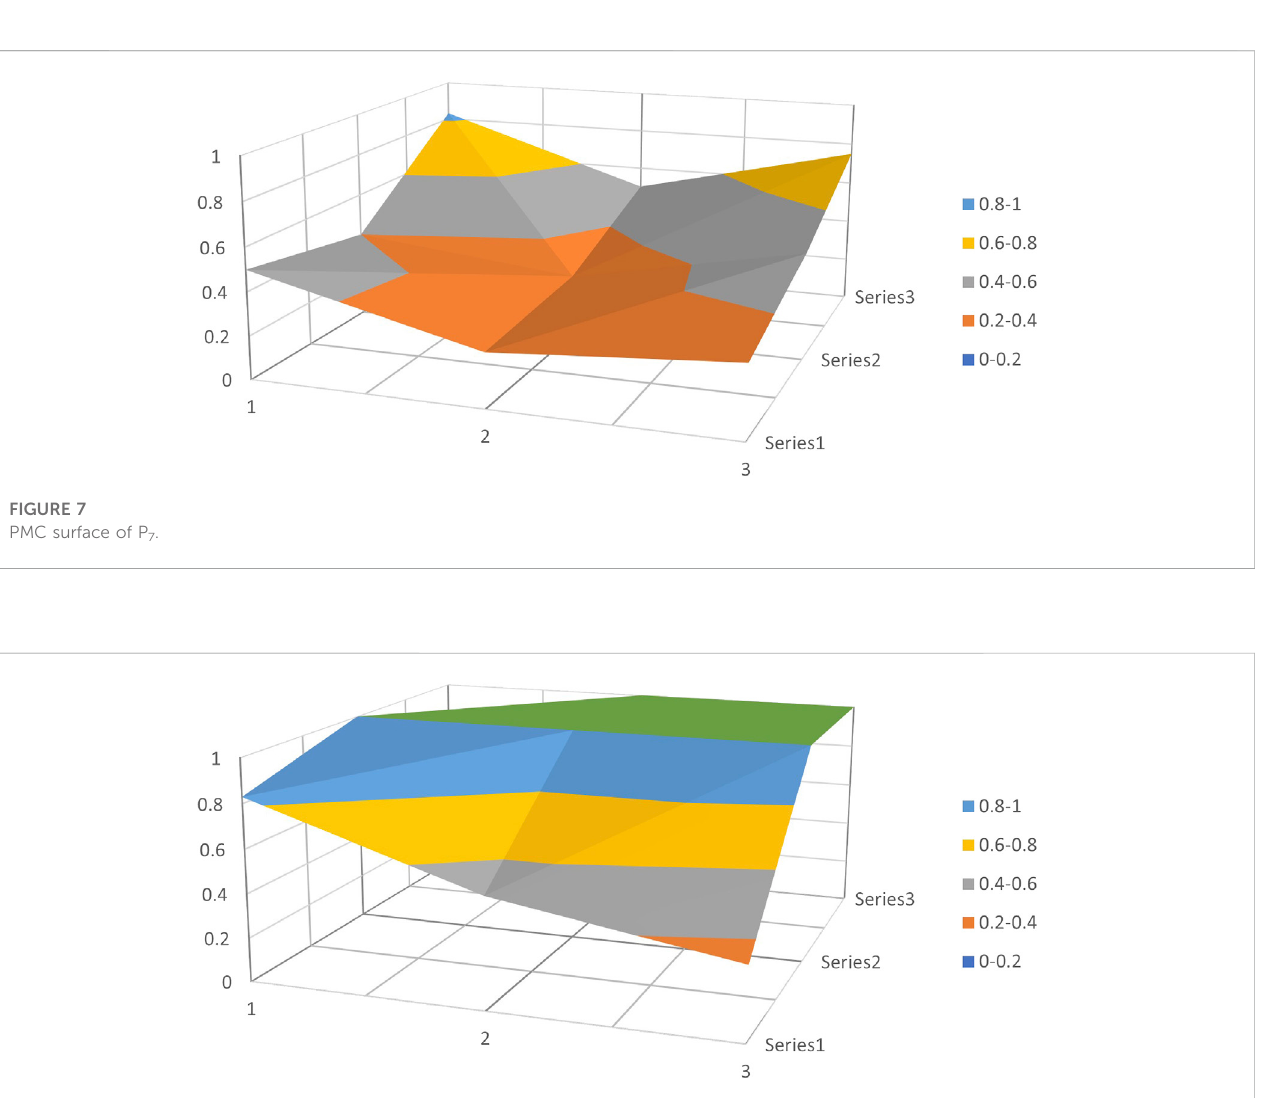
FIGURE 8 PMC surface of P 8